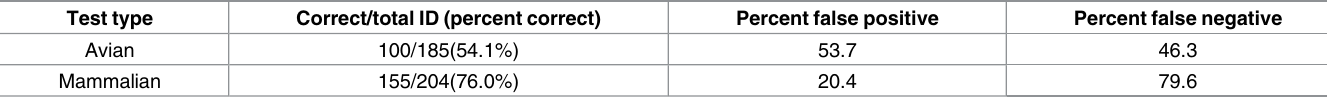
Table 2. Accuracyof subtype identification by RT-PCR (conventional and real-time). Test